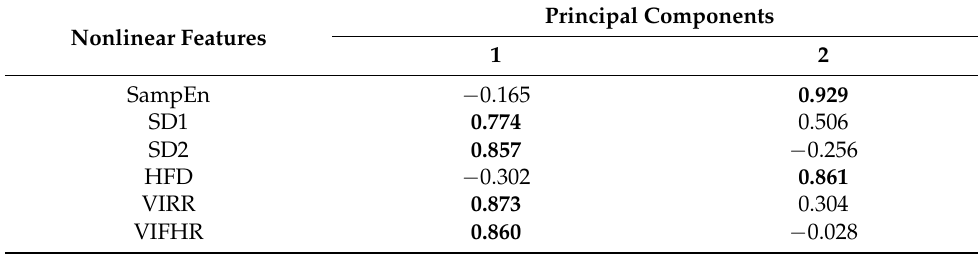
Table 3. Dimension reduction of nonlinear features of the FHRV.